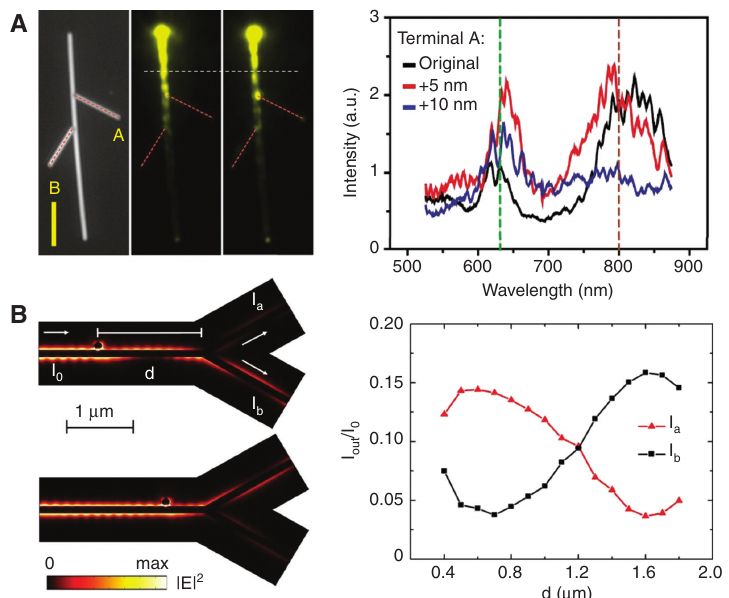
Figure 7: Control the routing of SPs in branched NW structures by changing dielectric environment (A) [44] and mode conversion (B) [78]. (A) Left: optical image of a branched NW structure (left) and QD fluorescence images for SPs on the original structure (middle, with 30 nm thick Al O layer) and with additional 5 nm Al O coating (right). The scale bar is 5 μ m. Right: emission spectra at terminal A for the original 2 3 2 3 structure (black), and for additional 5 nm (red) and 10 nm (blue) Al O layer deposited, respectively. (B) Left: field distributions for routing 2 3 SPs between two output branches using the particle-induced mode conversion. Right: output intensities at the two branches normalized by the input intensity I as a function of the particle position. Reproduced with permission from Refs. [44] and [78]. Copyright 2013 National 0 Academy of Sciences, USA (Ref. [44]), and Copyright 2014 Nature Publishing Group (Ref. [78]).